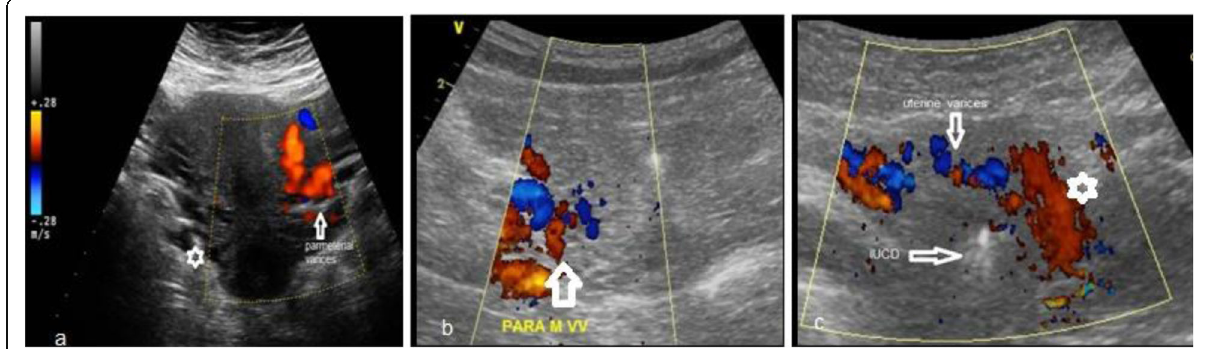
Fig. 2 a – c Trans-abdominal color Doppler images showing parametrial varices that appeared as a dilated hypoechoic cystic spaces (white asterisk) with venous reflux on raising the abdominal pressure, open white arrows in a and b, c transmyometrial varices were demonstrated (vertical white arrow) and the parametrial varices (white asterisk). The horizontal arrow in ( c ) pointed to the echogenic